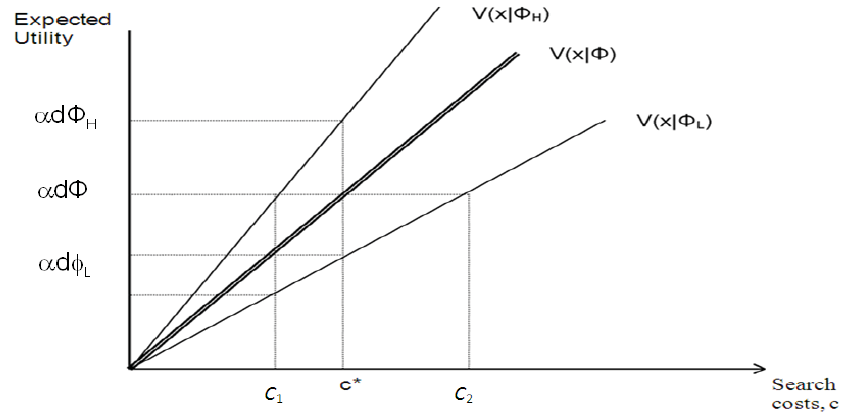
Fig. 3. Information search and gains from